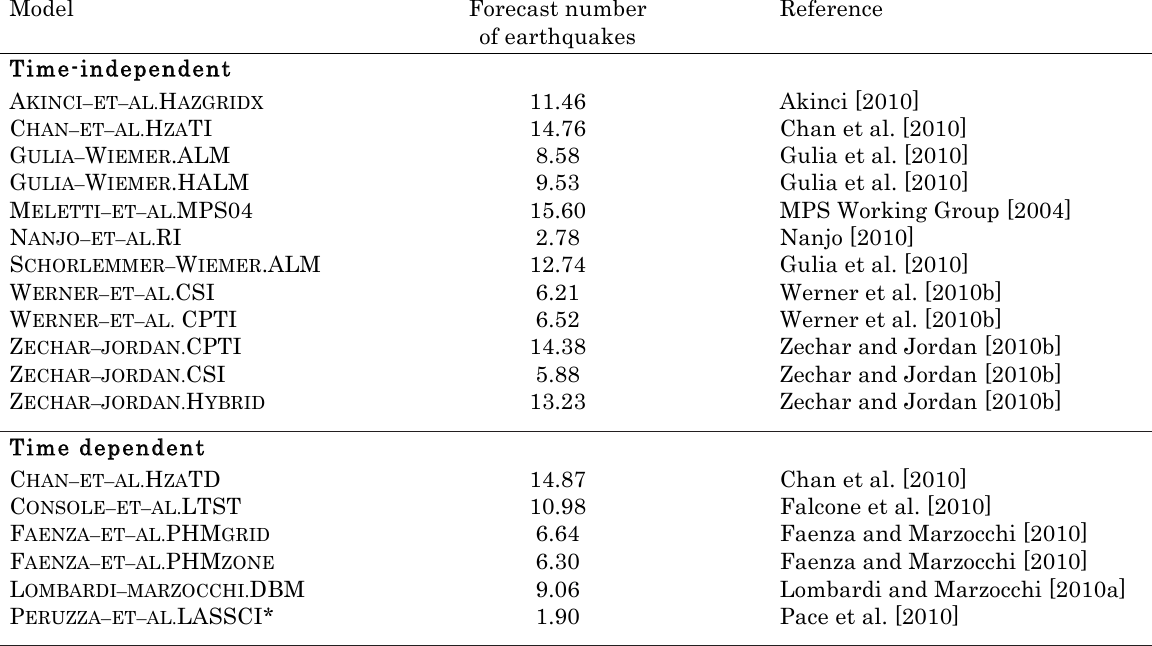
Table 1. Five-year and ten-year CSEP-Italy forecasts that are being evaluated within the European CSEP Testing Center at ETH Zurich. The forecasts